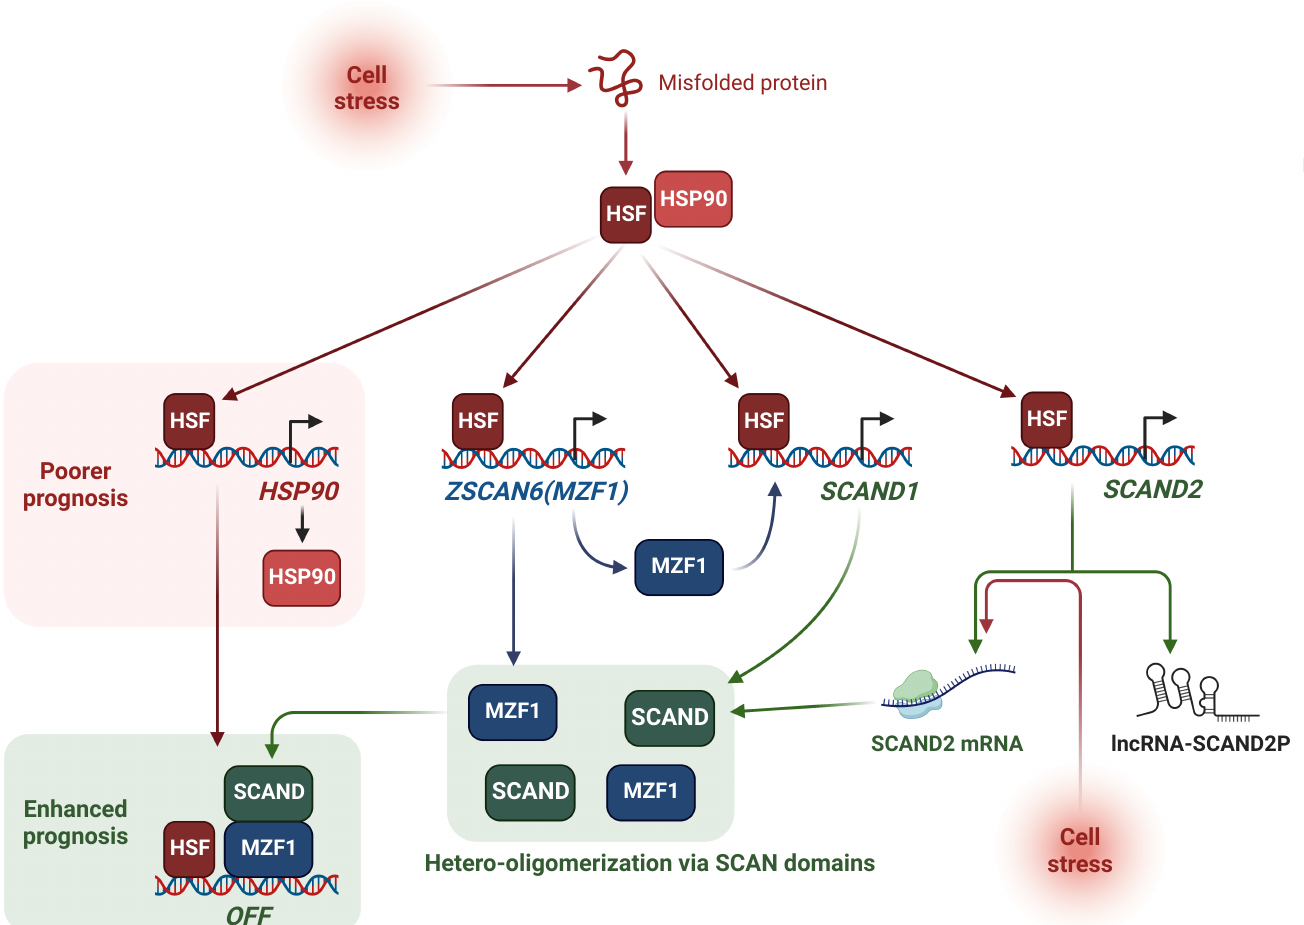
Figure 10. Stress-inducible SCAN transcription factors SCAND and MZF1 repress HSP90 gene expression. Cell stress activates HSF1 that binds to HSEs in the promoter regions of the HSP90 genes ( HSP90AA1 and HSP90AB1 ), ZSCAN6(MZF1) gene, and SCAND genes ( SCAND1 and SCAND2 ). MZF1 induces SCAND1 expression. Cell stress also switches the SCAND2 transcript variants from lncRNA-SCAND2P to SCAND2 mRNA. Hetero-oligomers of MZF1 and SCAND bind to and repress HSP90 genes. High expression of HSP90 is a biomarker of poorer prognosis, while SCAN-TF complexes repress the transcription of HSP90 gene and enhance the prognosis of cancer